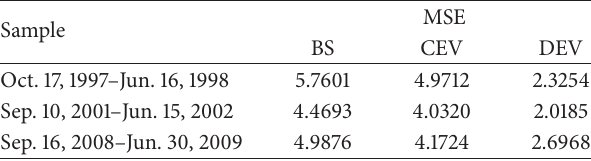
Table 2: Summary MSE of BS, CEV, and DEV models. Sample